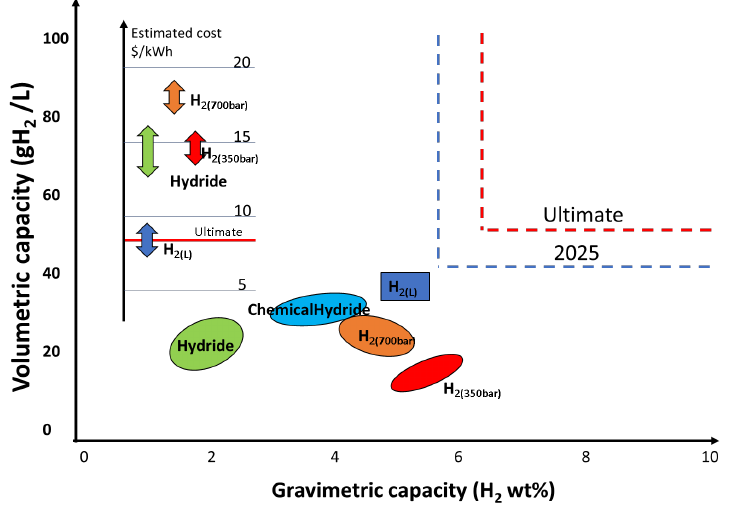
Figure 6. US DOE targets for hydrogen storage in terms of gravimetric and volumetric capacity [40], together with the current situation of the available storage strategies .